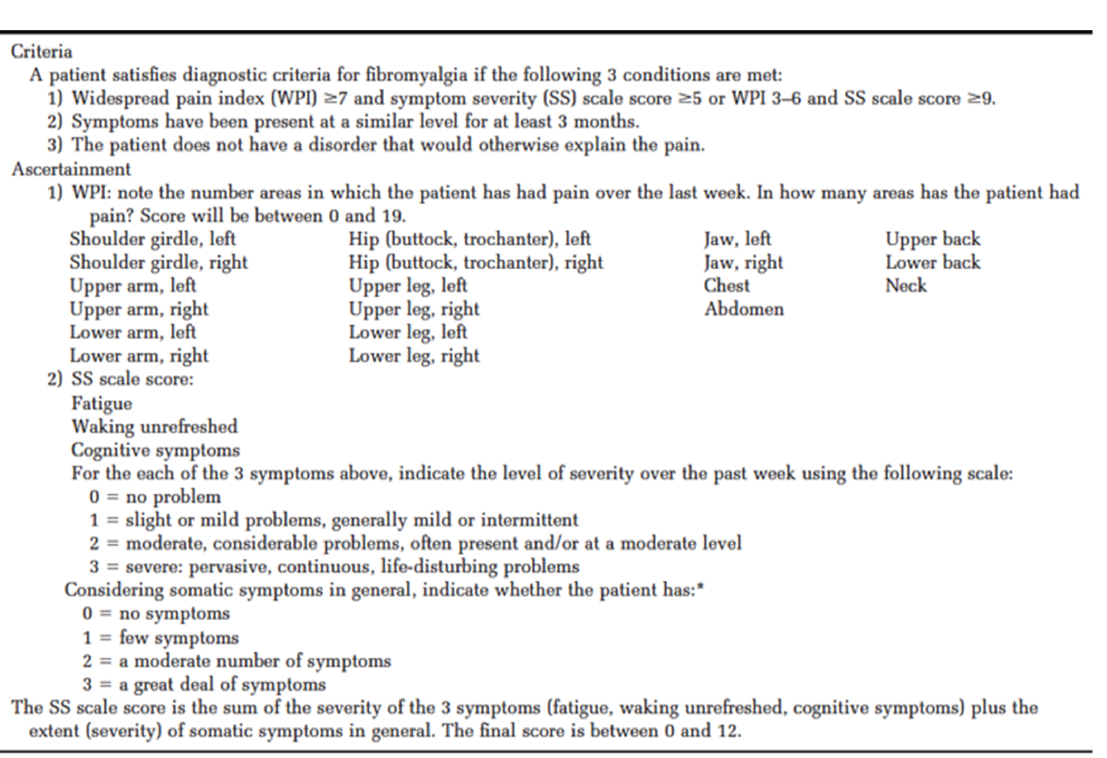
Figure 3. Symptoms of fibromyalgia according to the American College of Rheumatology [3]. ( A ) Variable importance (physician variables) in distinguishing fibromyalgia from controls, including the widespread pain index (WPI) and muscle symptoms. ( B ) Variable importance (physician vari- ables) in distinguishing fibromyalgia from controls, excluding the Regional Pain Scale (WPI) and muscle symptoms.